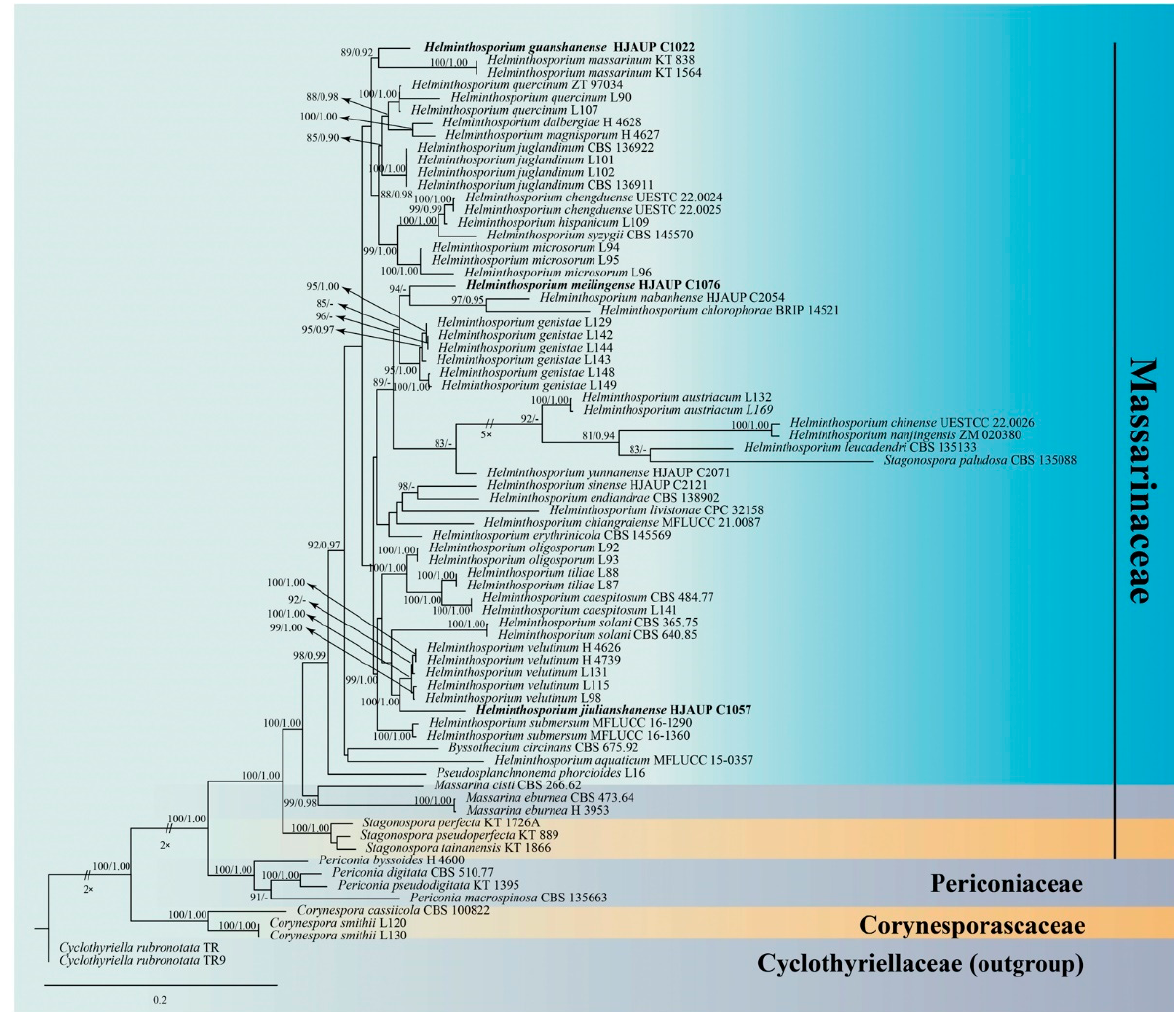
Figure 1. Phylogram generated from maximum-likelihood analysis based on combined ITS, LSU, SSU, TEF1 and RPB2 sequence data for the families Corynesporaceae , Massarinaceae and Periconiaceae . The ML and BI bootstrap support values above 75% and 0.90 are given above the nodes. The tree is rooted to Cyclothyriella rubronotata (TR) and C. rubronotata (TR9). Strains from the current study are in bold. Some branches were shortened according to the indicated multipliers.